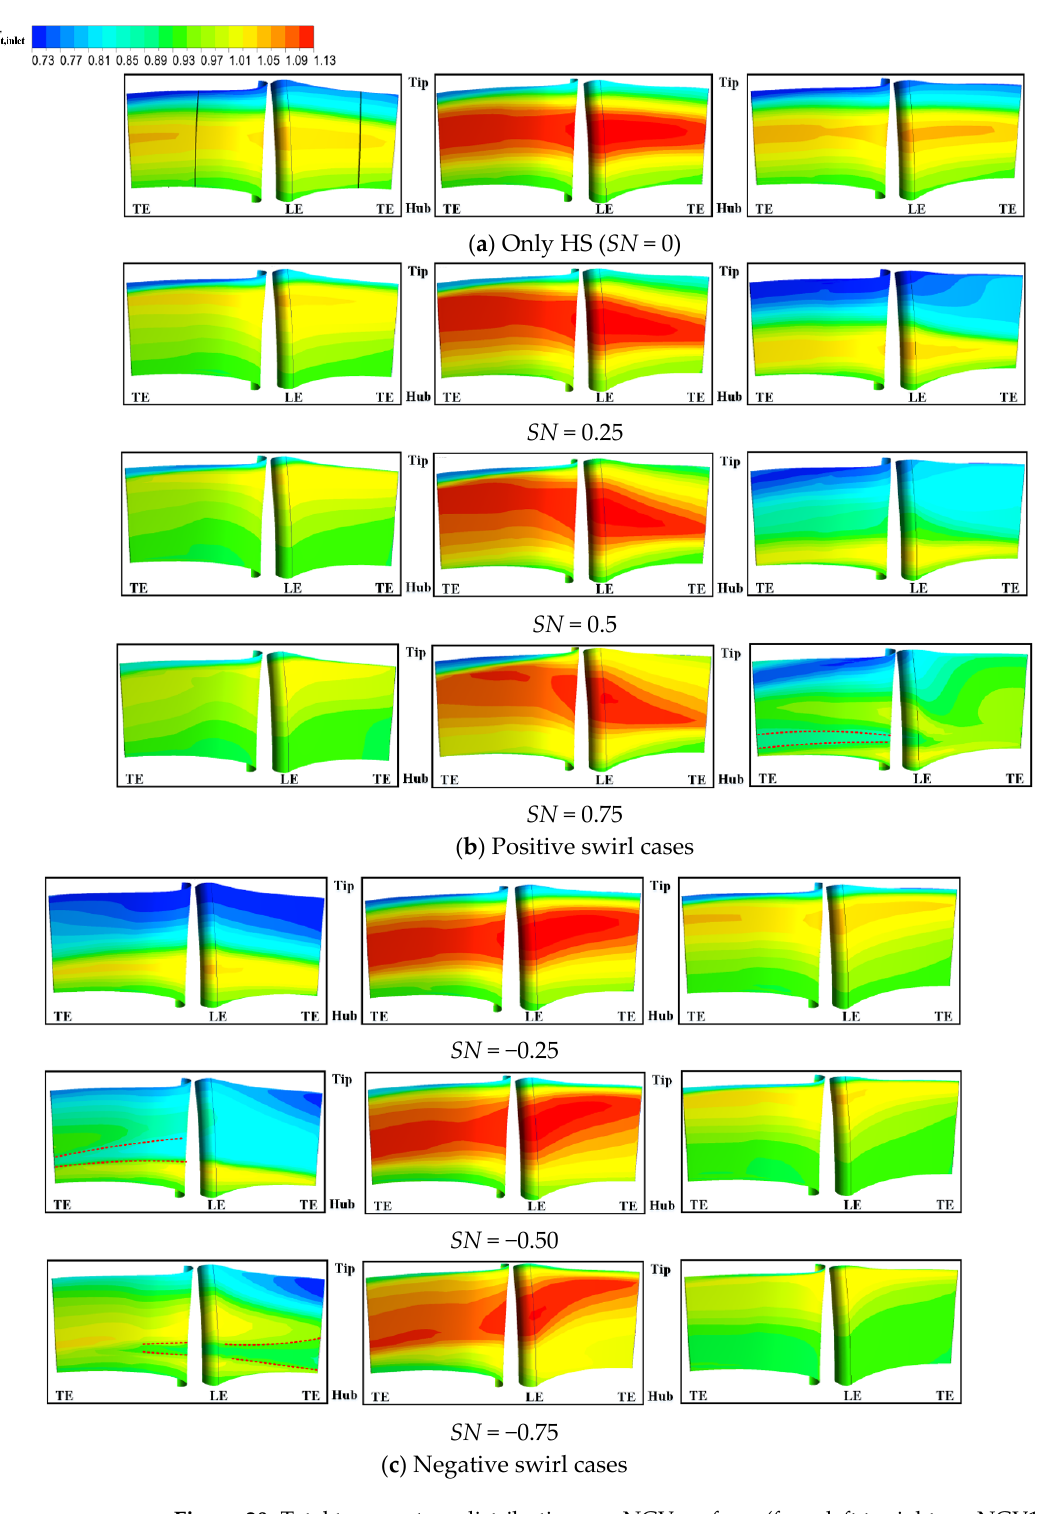
Figure 20. Total temperature distributions on NGV surfaces (from left to right are NGV1, NGV2 and NGV3, respectively).